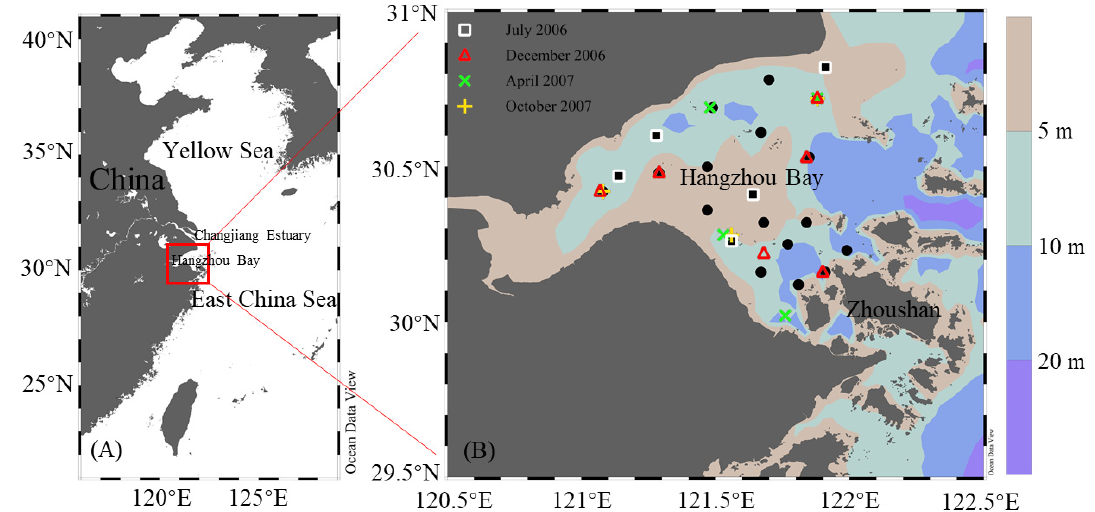
Figure 1. Area bounded by the red box in ( A ) shows the studied location in and off the HZB. ( B ) shows the sampling stations and the water depth in the HZB, black dots are Chl and environmental stations, and PP stations in July 2006, December 2006, April 2007 and October 2007 are shaped as white square, red triangles, green X and yellow +, respectively.